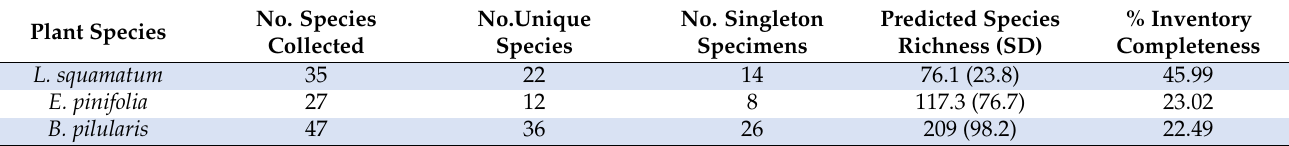
Figure 1. Rarefaction curves comparing species richness to sampling effort on the three fall-blooming shrubs. Significant differences are indicated by non-overlapping 95% confidence intervals. Table 8. Total number of species, unique species (found only on one host; includes singletons), and singletons (those with only one specimen collected through all sampling) collected on each plant species. Furthermore, the predicted species richness and percent inventory completeness (as predicted by the Chao 2 estimator) collected on each plant host.